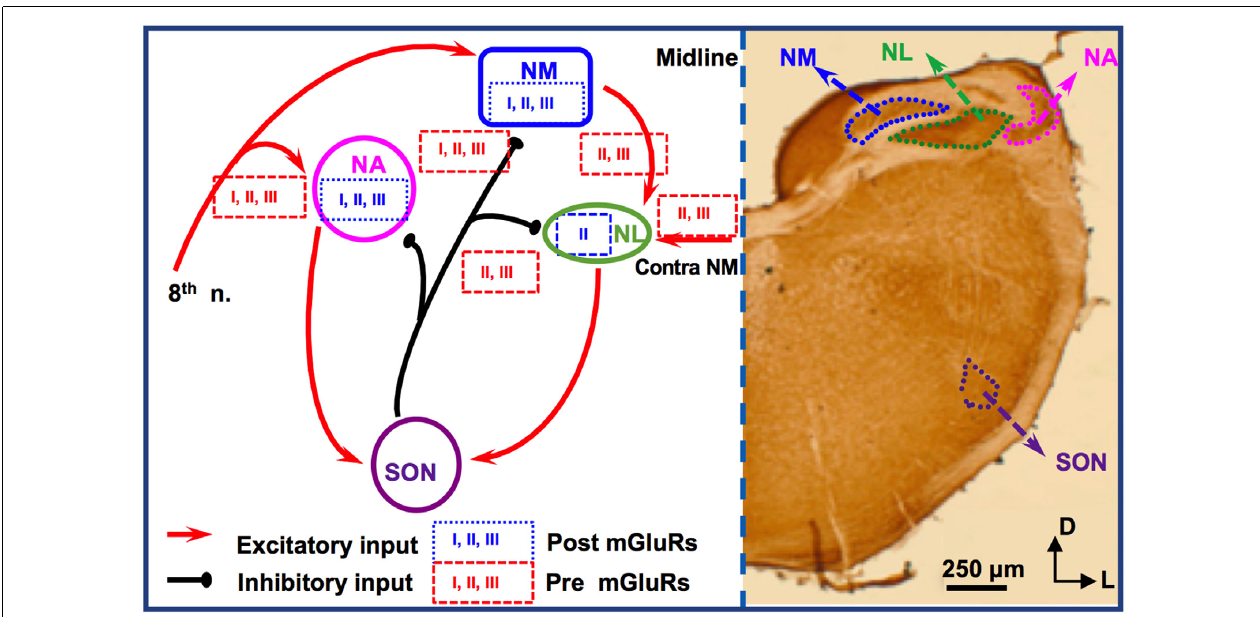
FIGURE 2 | mGluR modulation in the avian brainstem interaural time differences (ITD) pathway. Modulation of neuronal properties by mGluRs has been observed at the ITD-coding site nucleus laminaris (NL), as well as the excitatory input nucleus, nucleus magnocellularis (NM). At the NL, postsynaptic group II mGluRs interact with K V channels, enhancing high frequency (HF) following ability. Presynaptic groups II and III mGluRs co-regulate both the excitatory and inhibitory transmission at NL. Importantly, this modulation varies depending on the coding-frequency region. At the NM, mGluRs on the presynaptic terminals exert fine control on the strength of the inhibitory input from superior olivary nucleus (SON), and postsynaptic mGluRs help maintain Ca 2+ homeostasis. Data on mGluR modulation of neuronal properties of SON neurons is still